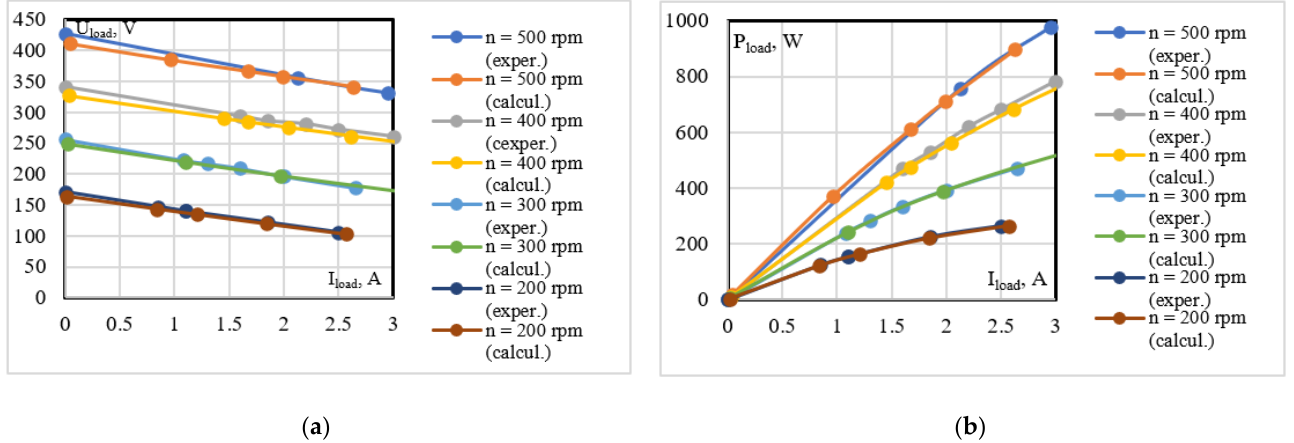
Figure 13. Output characteristics of the tangential machine with N42 PMs: ( a ) terminal voltage vs. load current, ( b ) output power vs. load current.